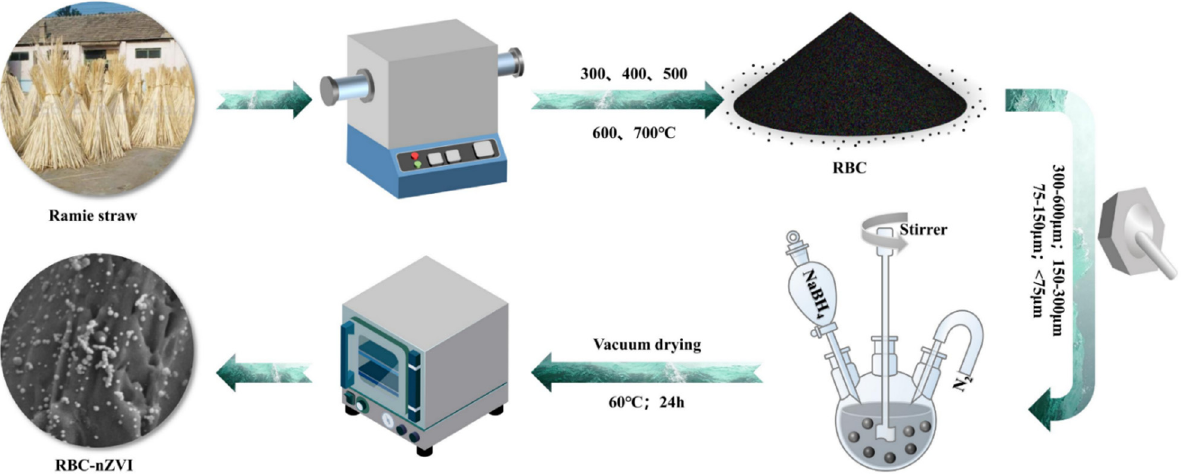
Figure 1. Preparation process of RBC/nZVI composite.